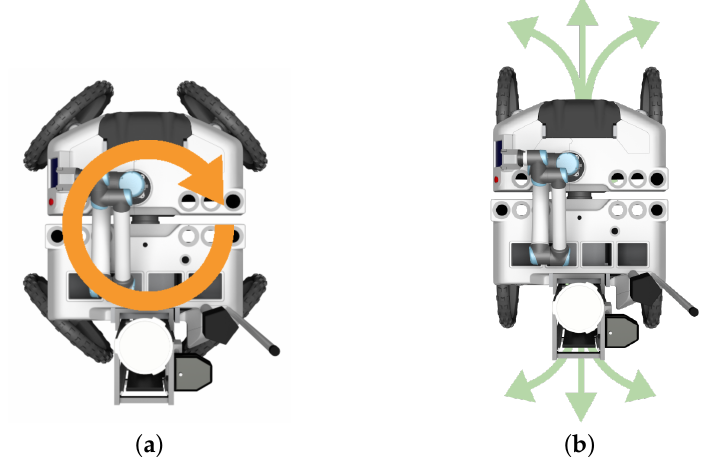
Figure 7. UGV’s possible motions attainable by the robot in two different locomotion modes. ( a ) The orange arrow depicts the type of motion that the robot can attain when in the turning point; ( b ) the green arrows depict the type of motion that the robot can perform with double Ackerman